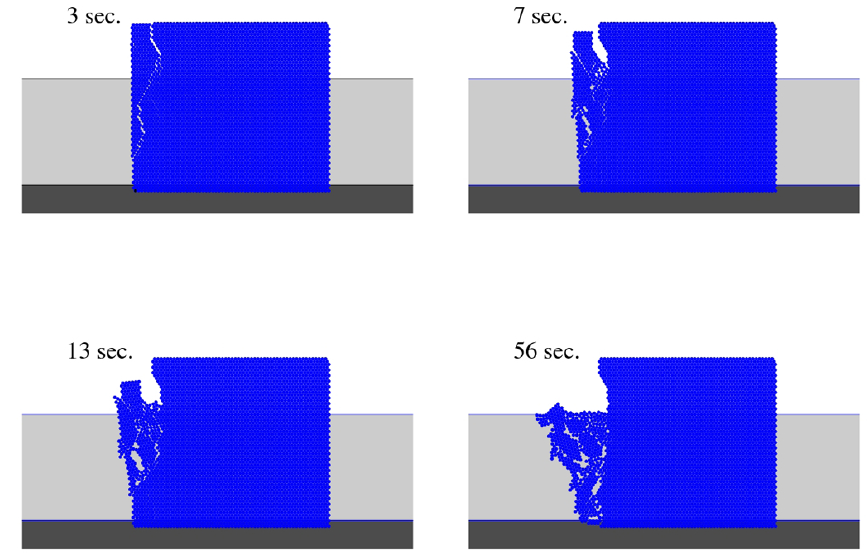
Fig. 3. Snapshots of a calving ice-block. The size of the block is 30m × 30m. The block rests on a soft substrate that efficiently hinders the block from sliding, thus resembling, e.g. a muddy sea floor. The block is immersed in 20m of water. The simulation times of the snapshots are